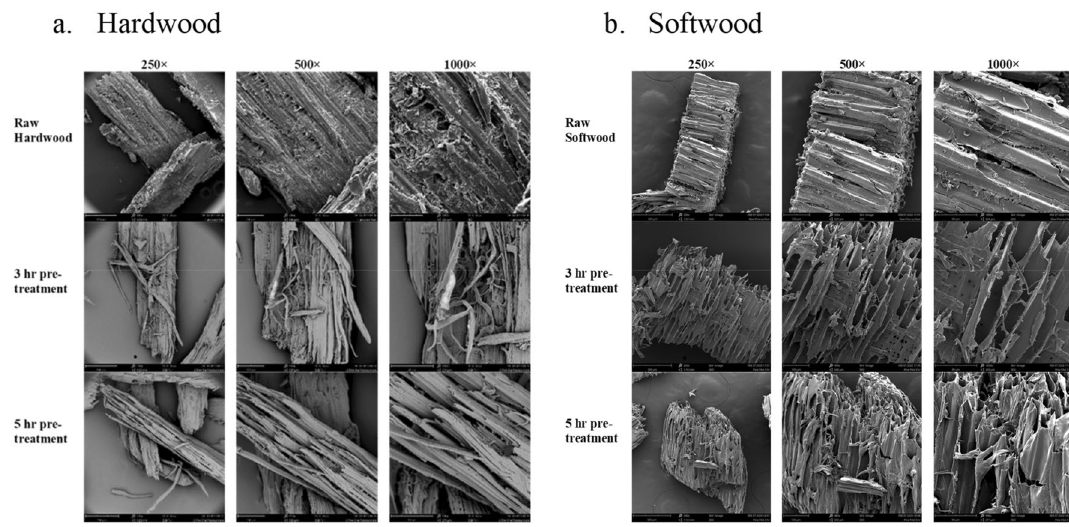
Figure 3. Surface morphology of untreated and acid pretreated